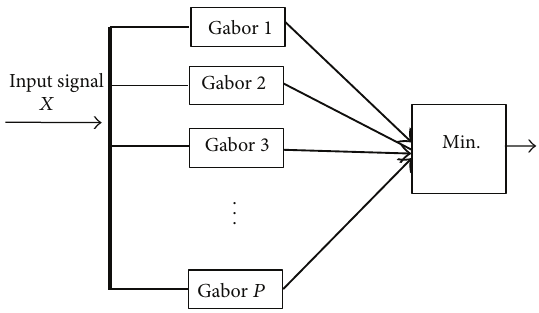
Figure 3: Testing scheme for modulation